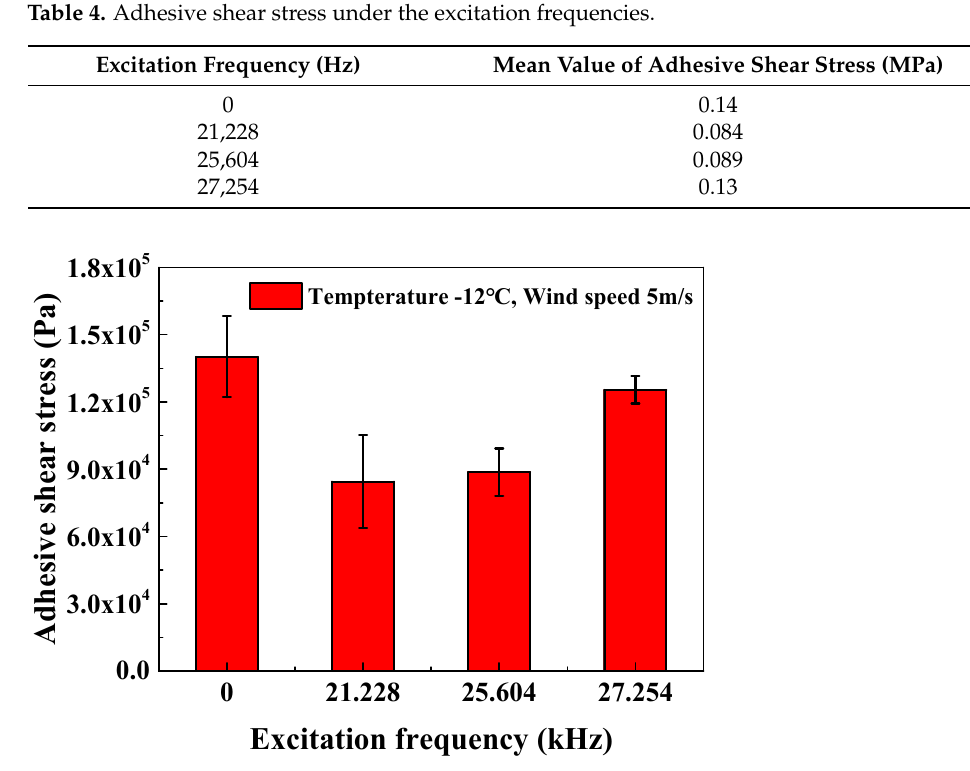
Figure 13. Adhesive shear stress of the ice.